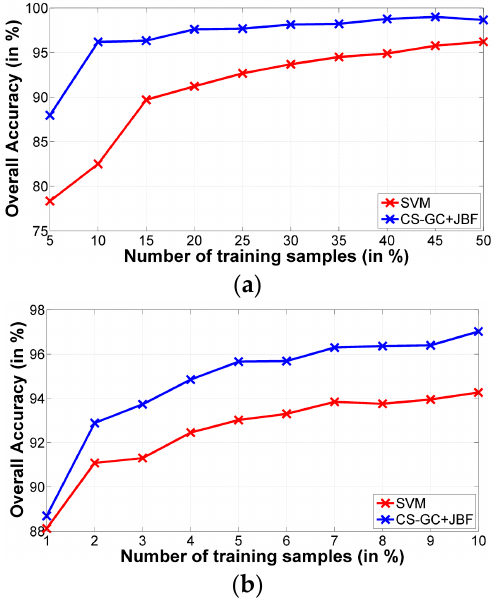
Figure 15. Effect of number of training samples on proposed CS-GC + JBF and SVM for the two hyperspectral data sets: ( a ) Indian pines; and ( b ) University of Pavia.